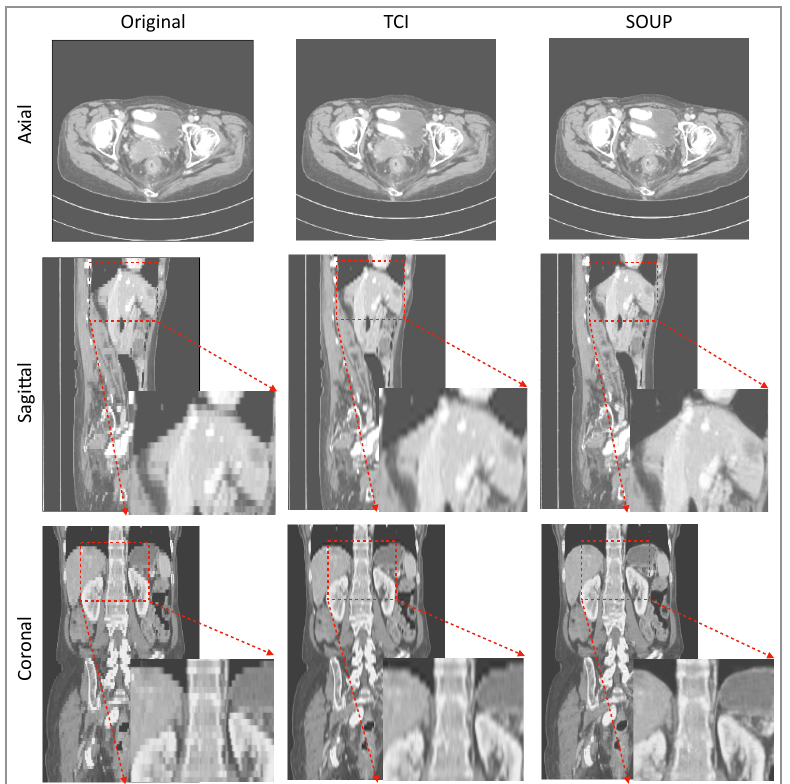
Figure 6. Example of SR interpolation on CT with a sampling factor equal to 4.8. Edges and textual details are better resolved by SR. Blurring is reduced. TCI: tricubic interpolation.